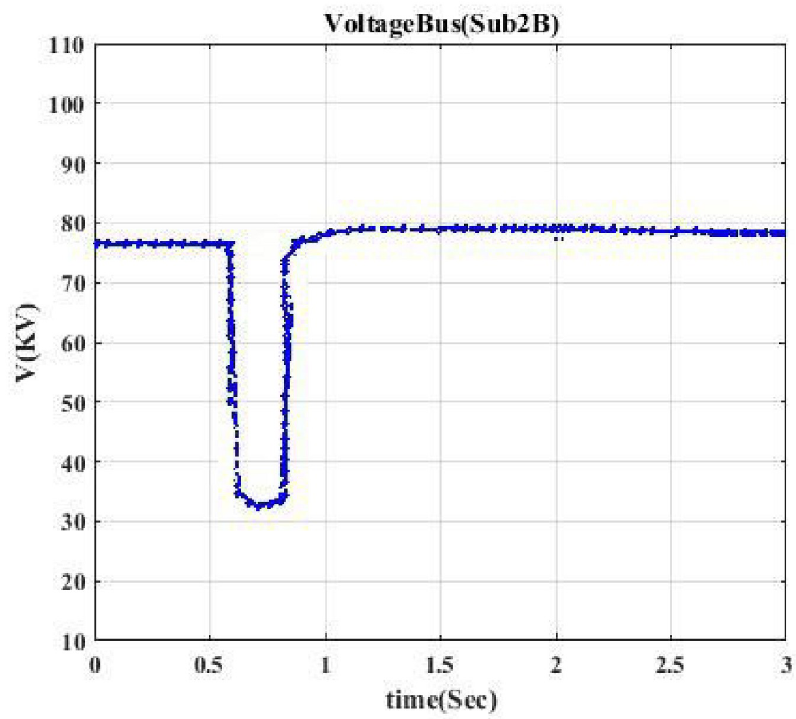
Fig 10. Voltage profile for switching the static load. This curve indicates the voltage curve when the static load is disconnected from the system.